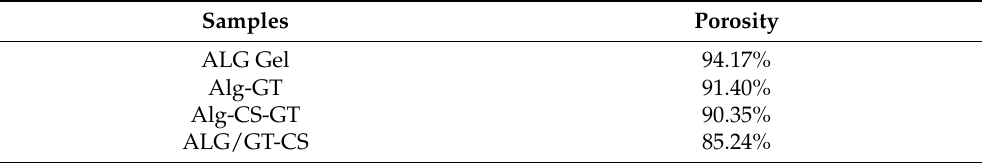
Table 3. Porosity of ALG Gel, Alg-GT, Alg-CS-GT and ALG/GT-CS.